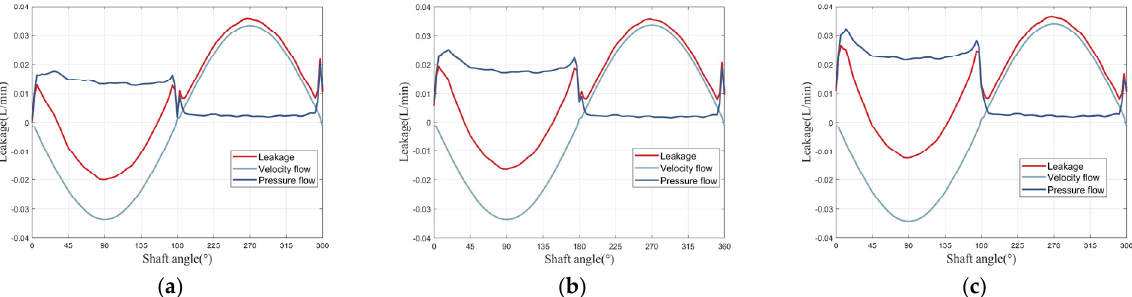
Figure 13. Comparison of the leakage of the piston–cylinder interface: ( a ) Condition 1; ( b ) Condition 2; and ( c ) Condition 3.